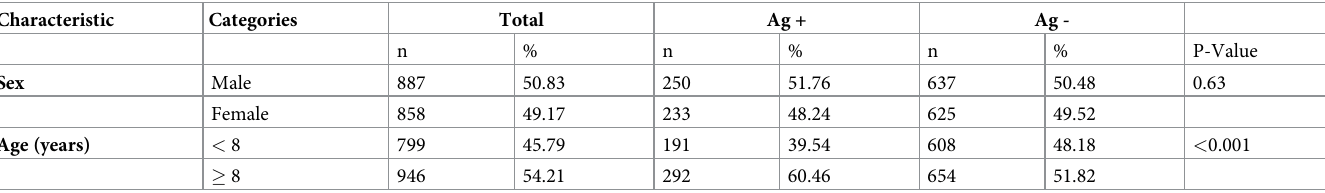
Table 2. Age and sex as possible risk factors for T . solium antigen seropositivity.